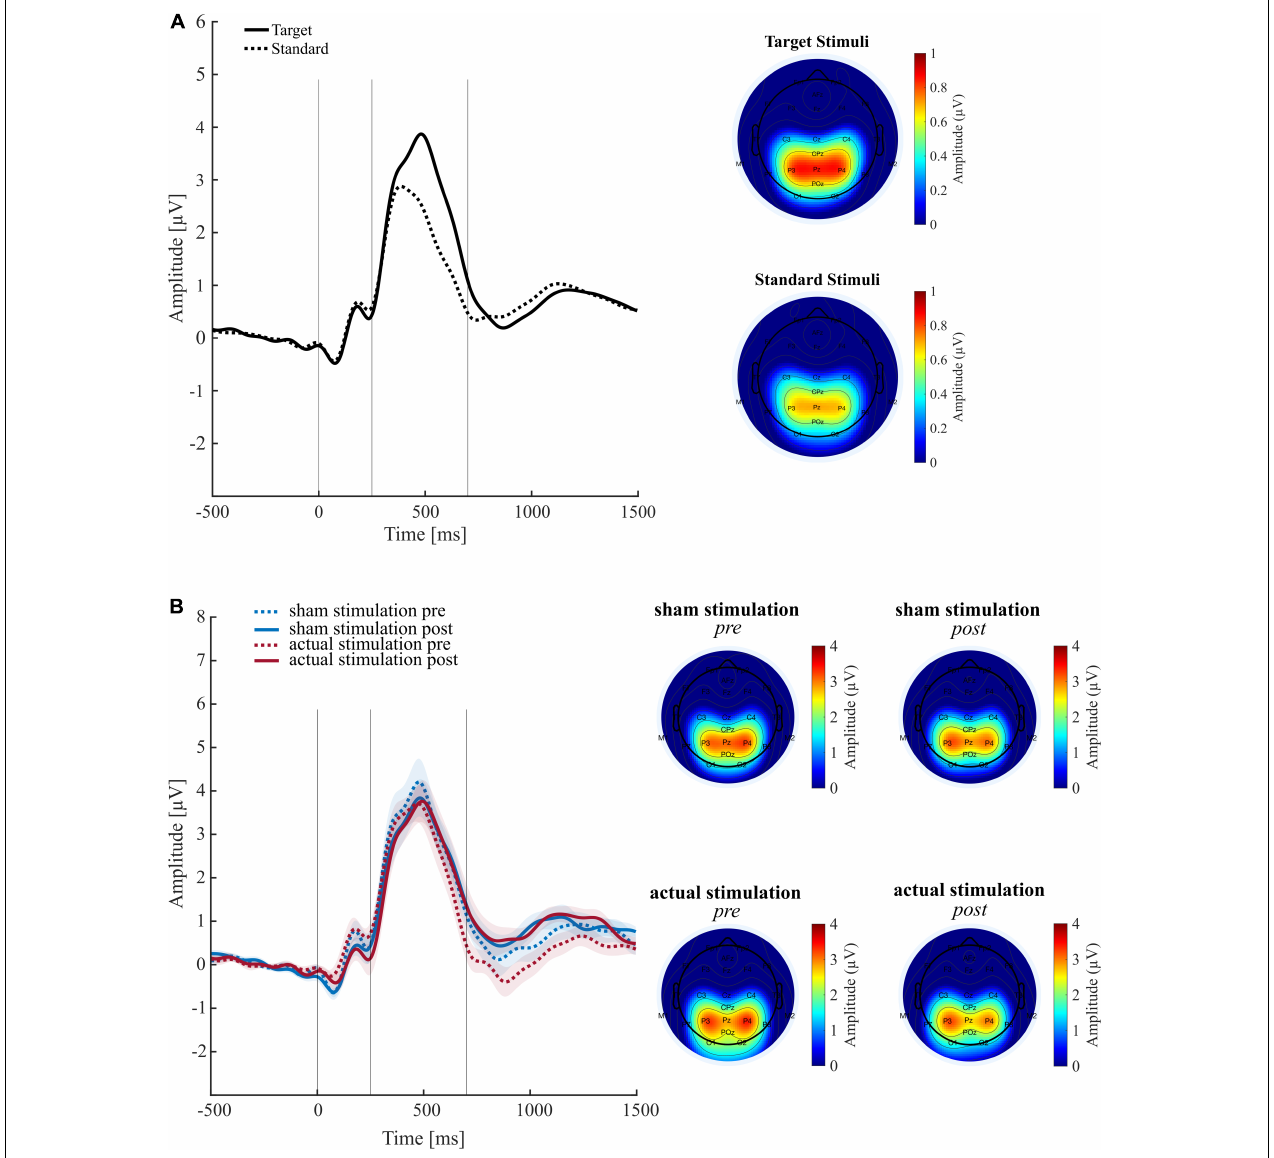
FIGURE 5 | Results of the event related potential (ERP) analyses. (A) Grand average ERP waveforms (left panel) and associated topographies (right panel) across all conditions for target and standard stimuli. (B) Target P300 ERPs (left panel) and associated topographies (right panel) for each main experimental condition. Shaded curves reflect the standard error of the mean. Time windows for statistical analysis are depicted in the entire 250–550 ms time